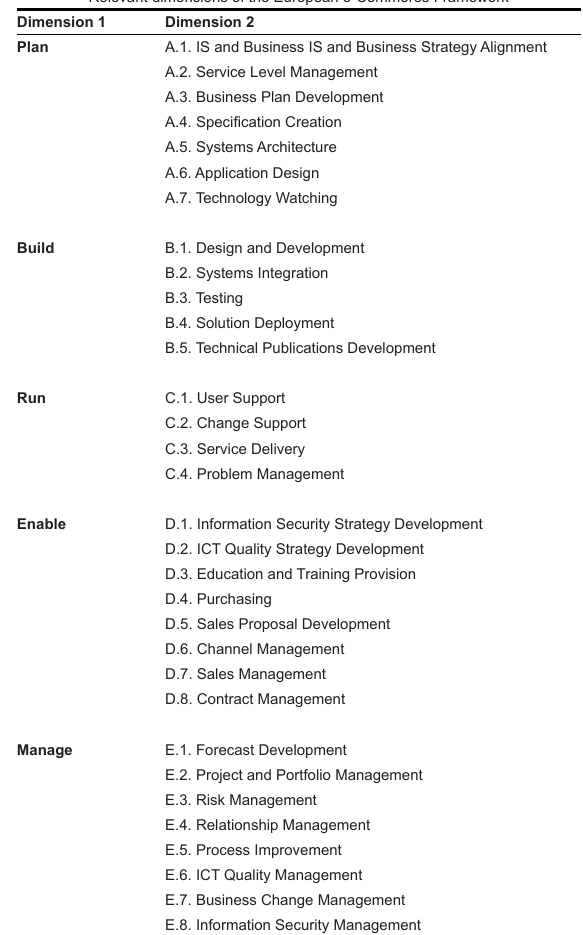
TABLE 1 Relevant dimensions of the European e-Commerce